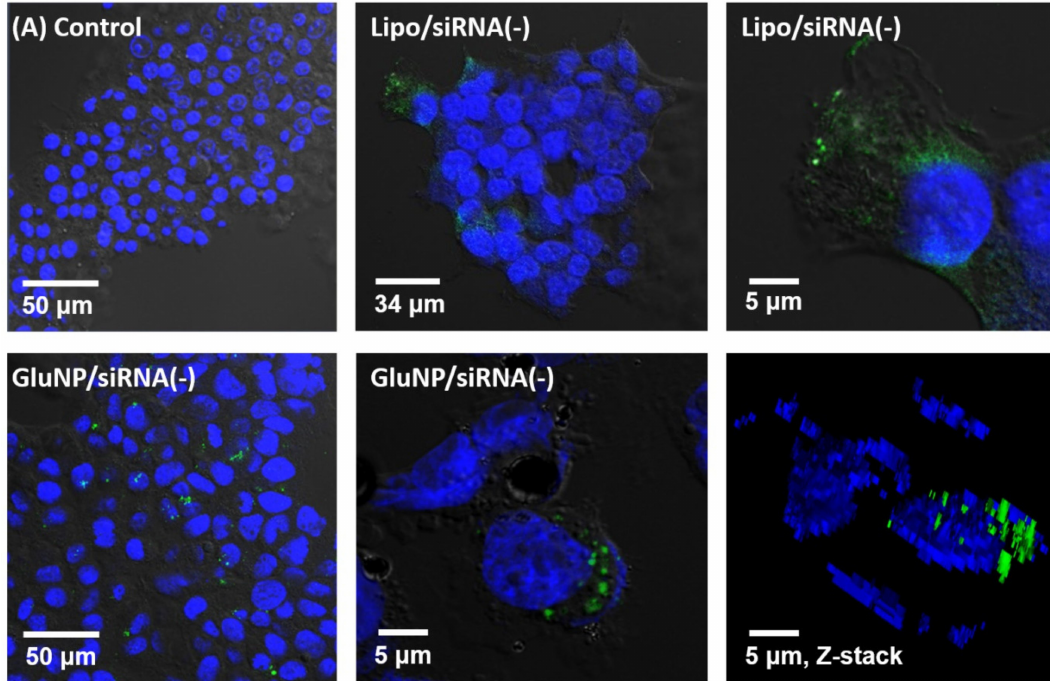
Figure 4. Cellular uptake of siRNA alone (negative control) or with Lipofectamine (positive control) or GluNPs (experimental group). Both Lipofectamine and GluNPs enabled the internalization of siRNA by the HEK293T